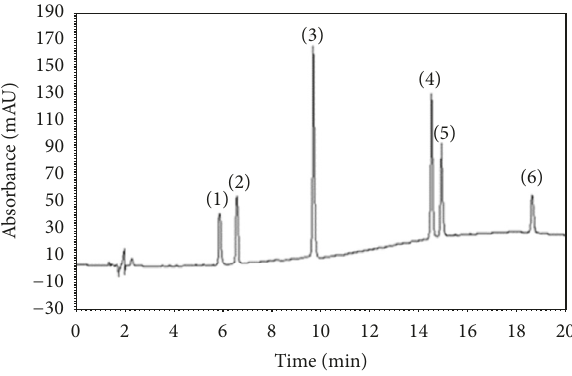
Figure 1: LC-UV/DAD chromatogram obtained by the direct injection of a standard solution of the target isoflavones at the concentration level of 2 𝜇 g/ml. Peak legend: (1) daidzin, (2) glycitin, (3) genistin, (4) daidzein, (5) glycitein, and (6) genistein.